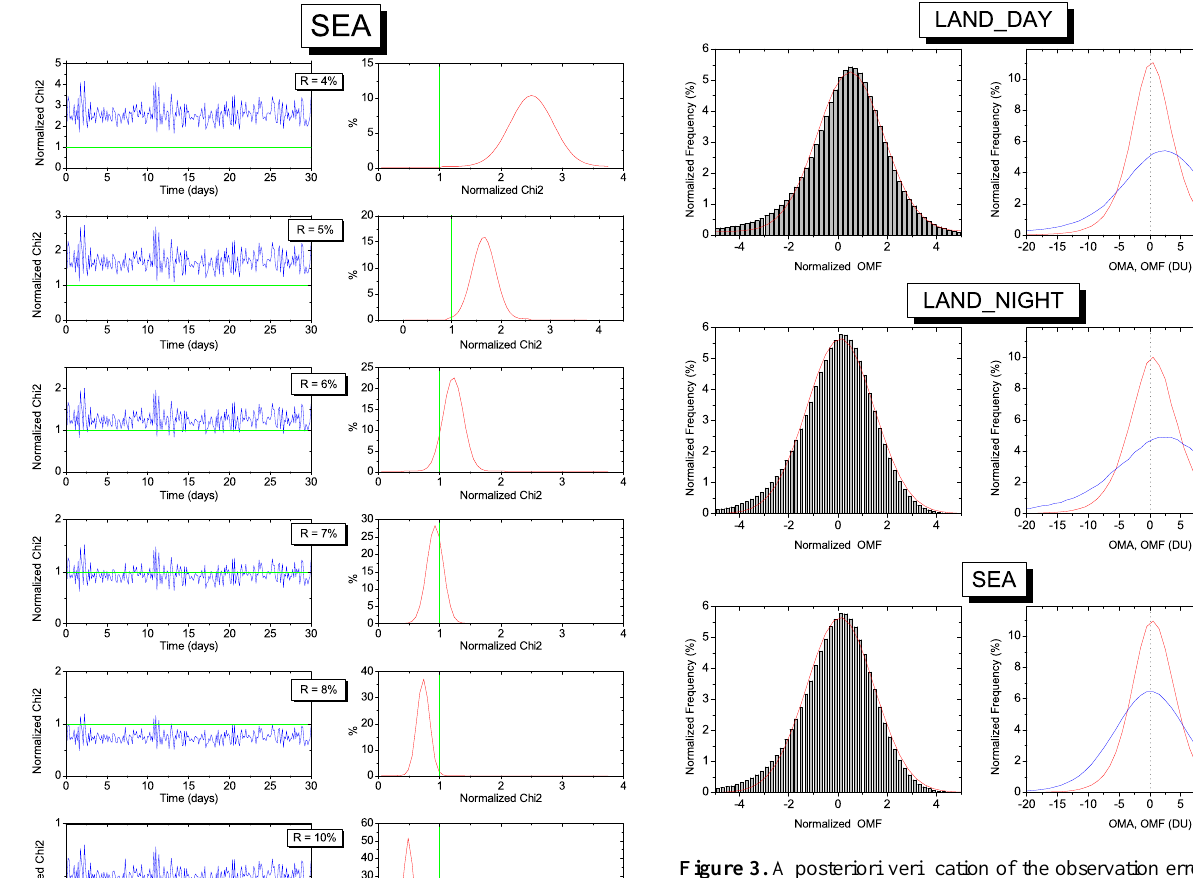
Figure 3. A posteriori verification of the observation error specifi- Fig. 3. A posteriori verification of the observation error specification for the analyses issued from the MOPITT cation for the analyses issued from the MOPITT CO total column CO total column for which the observation errors are estimated using the proposed method. (Left): histograms for which the observation errors are estimated using the proposed method. Left: histograms of OMF (observation minus forecast) dif- of OMF (Observations Minus Forecast) differences normalized by the specified observation errors. The red line ferences normalized by the specified observation errors. The red line is a Gaussian fit to the histogram. The good agreement between the histogram and the fit function supports the Figure 2. Example of χ 2 diagnostic used to estimate the error of is a Gaussian fit to the histogram. The good agreement between the Fig. 2. Example of χ 2 diagnostic used to estimate the error of the total column for observations made over the total column for observations made over sea. Left: time evolu- assumption of Gaussian errors in the observations and the forecast. (Right): histograms of Observations Minus histogram and the fit function supports the assumption of Gaussian sea. (Left): time evolution of the normalized χ 2 value over the month of August 2008 for different values of tion of the normalized χ 2 value over the month of August 2008 for errors in the observations and the forecast. Right: histograms of ob- Analysis (OMA: red lines) and OMF (blue lines). different values of observation error. Right: the Gaussian fit of the observation error (Right): the Gaussian fit of the corresponding normalized histogram. The mean as well as the servation minus analysis (OMA: red lines) and OMF (blue corresponding normalized histogram. The mean as well as the me- median values of χ 2 for each observation error value are reported in Table 1. dian values of χ 2 for each observation error value are reported in Table 1.